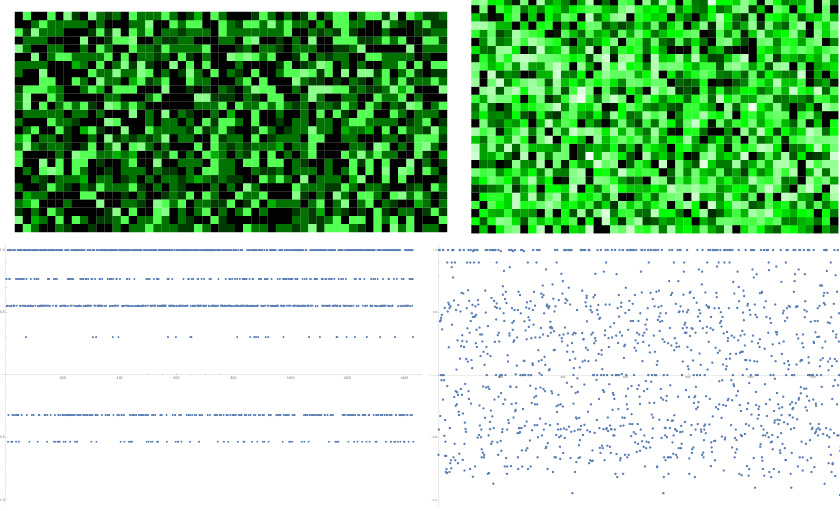
Figure 1: A visualization of the F -symbol matrix elements in a unitary gauge, on the [ 11–13 ] , and on the right is left is H 3 All values are